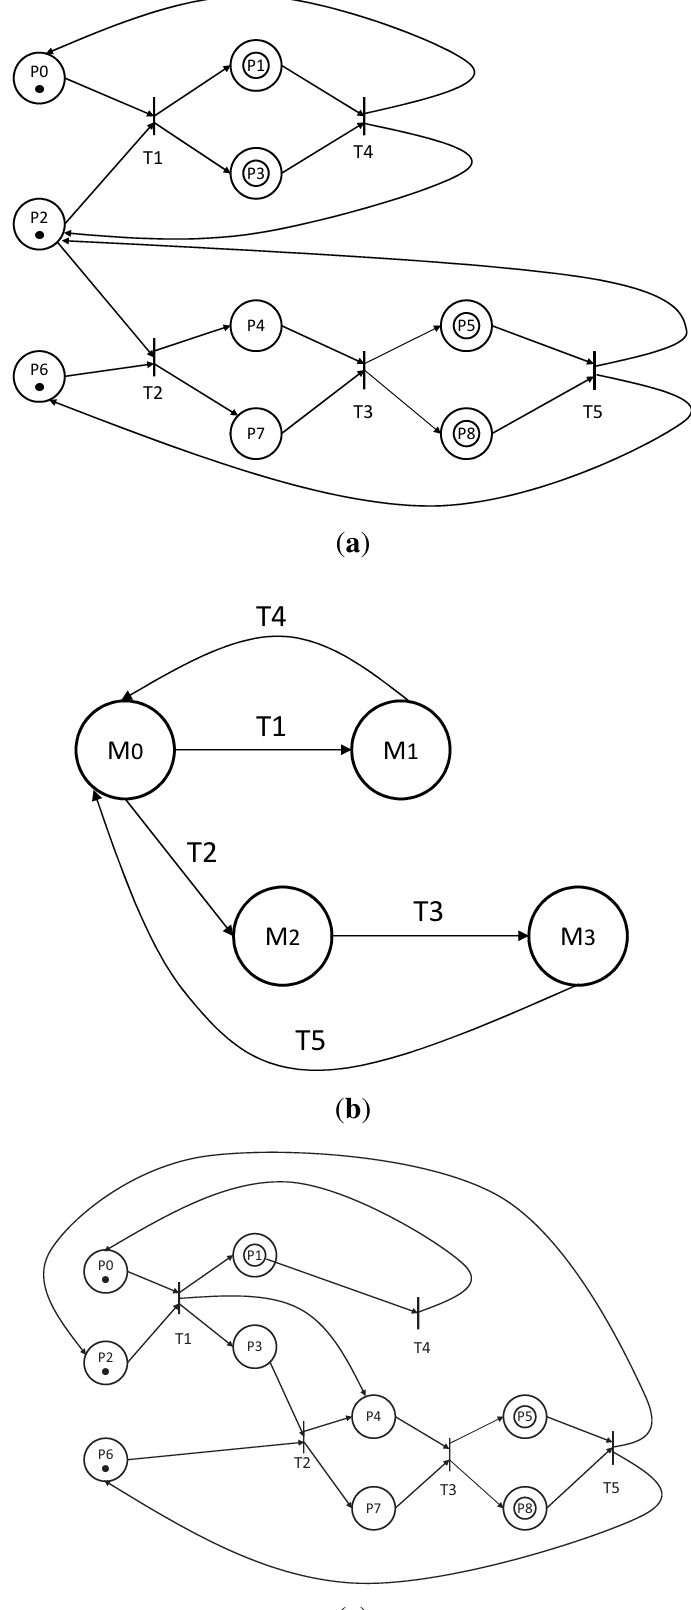
Figure 8. Collaboration scheme design using a Petri-net (PN) graph for three agents. ( a ) a reachable PN model; ( b ) the state reachability graph of a valid collaboration model; ( c ) an unreachable PN